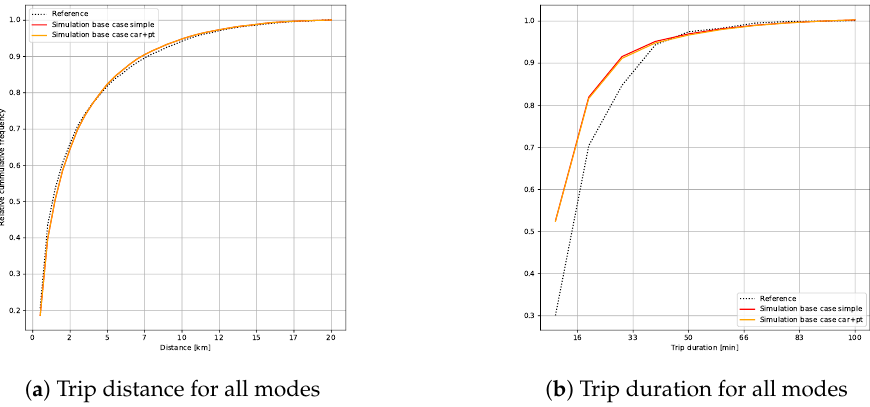
Figure 6. Distribution of trip distances and durations for all modes from simulation and